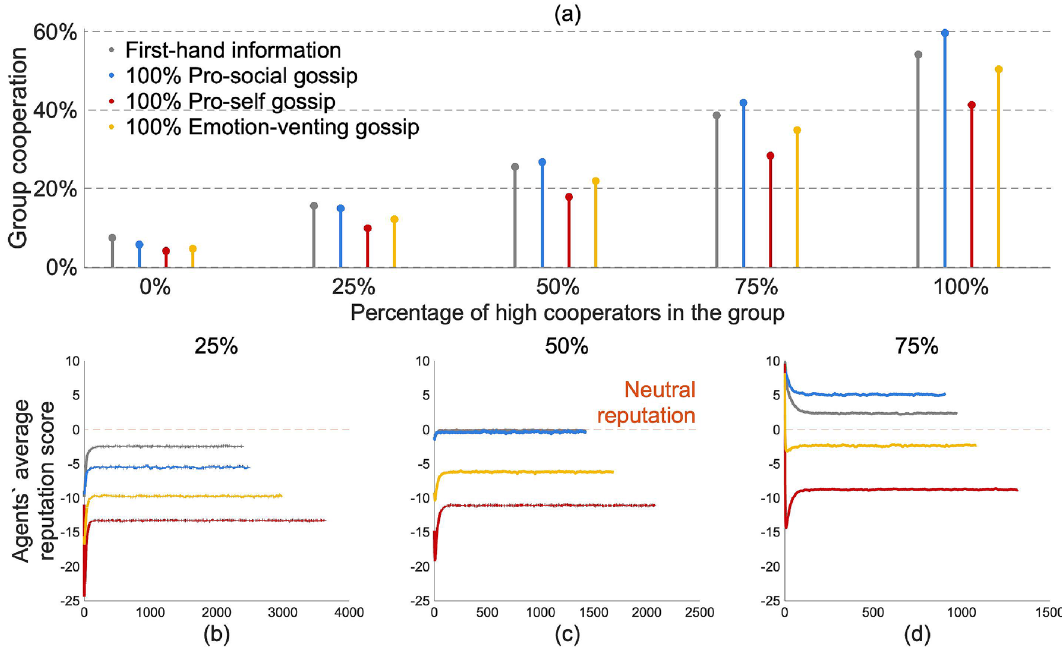
Figure 4. Results for conditionally cooperating agents when they were randomly matched and the group varied with respect to the agents’ initial propensity to cooperate. ( a ) Average group cooperation for different percentages of high cooperators in the group. High cooperators have an initial chance to cooperate around 70 % (normal distribution N ( 70, 5 ) ); low cooperators have an initial chance to cooperate around 30 % (normal distribution N ( 30, 5 ) ). Agents’ average reputation of the rest of the group when agents were randomly matched, and the group was composed of ( b ) 25 % high cooperators, ( c ) 50 % high cooperators, and ( d ) 75 % high